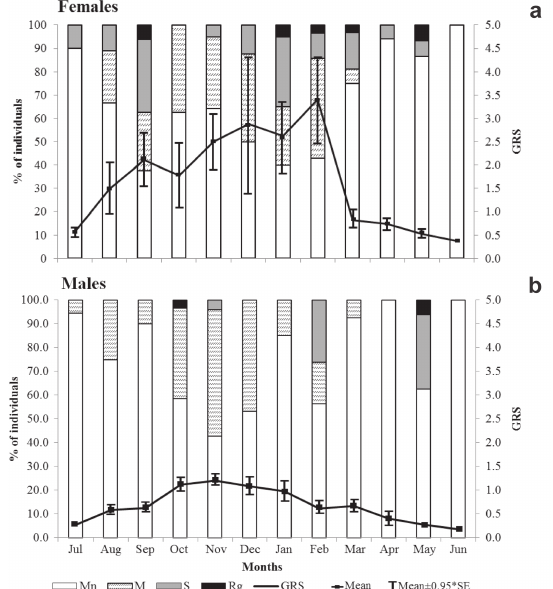
Fig. 5. Monthly distribution of the gonadal maturation stages and the average gonadal somatic relationship (± SE) for females and males of Salminus brasiliensis from the Upper Uruguay River between April 1996 and February 2014. a. Females; b. Males. I = Immature; Mn = Maturing; M = Mature; S = Spent; Rg =